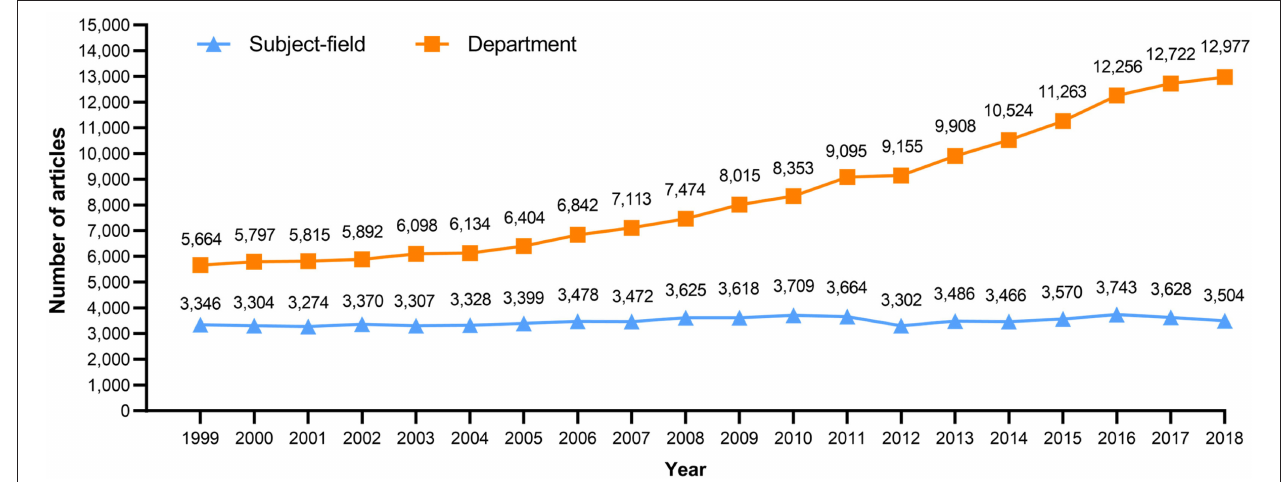
FIGURE 2 | Trend of articles published in the subject-field dataset and the department dataset from 1999 to